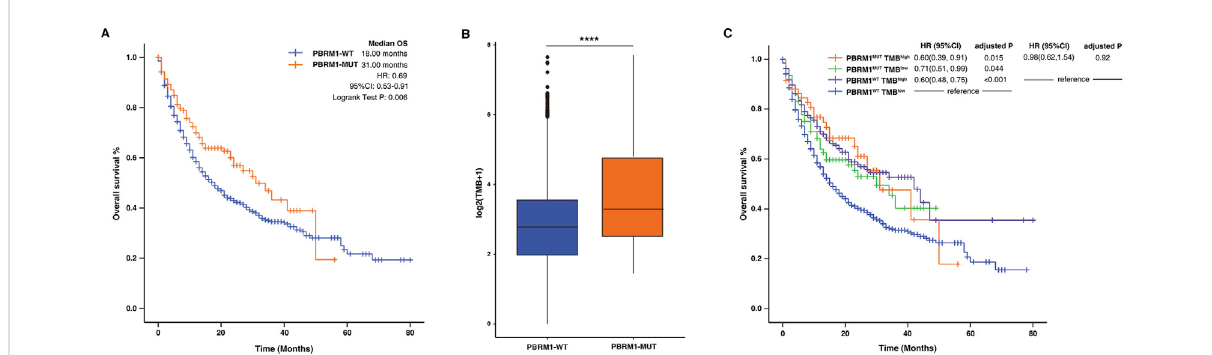
FIGURE 3 Association between PBRM1mutation and ICIs ef fi cacy in the validation cohort. (A) The Kaplan-Meier survival analysis comparing OS between PBRM1-MUT and PBRM1-WT patients in the validation cohort. (B) Comparison of the TMB between PBRM1-WT and PBRM1-MUT tumors in validation cohort. (C) The Kaplan-Meier curves comparing OS among PBRM1 MUT TMB high , PBRM1 MUT TMB low , PBRM1 WT TMB high , and PBRM1 WT TMB low groups in the validation cohort. **** p <